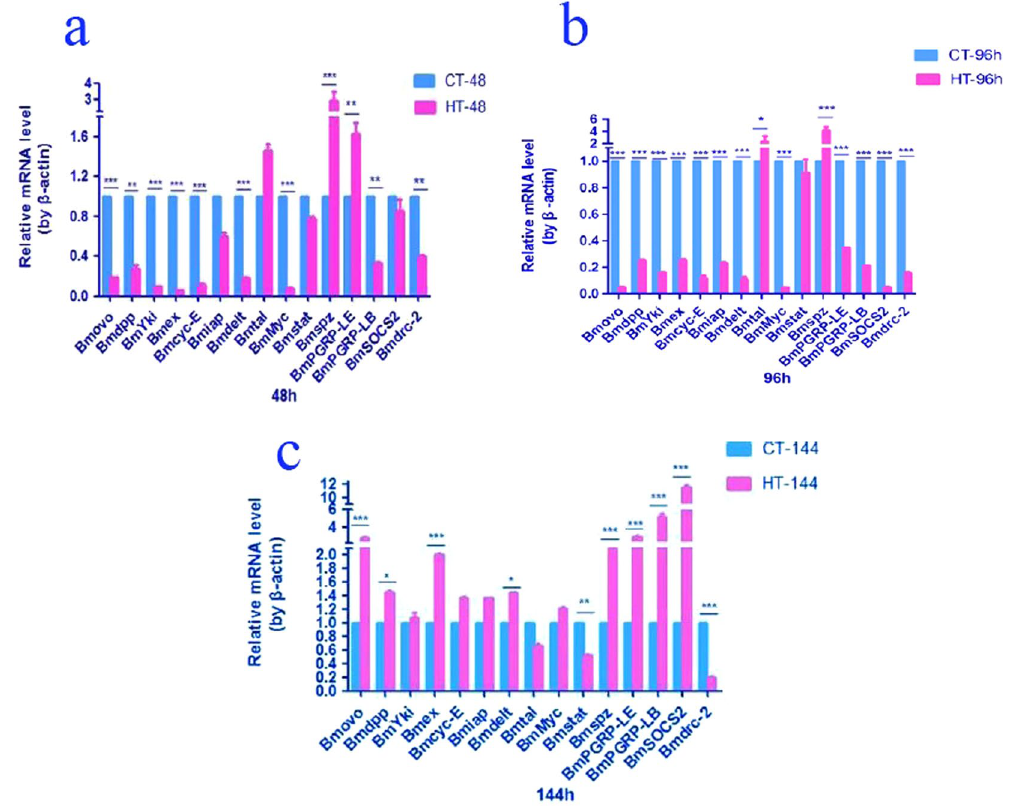
Figure 9. Comparison of gene expression levels in the midgut between control and THTT